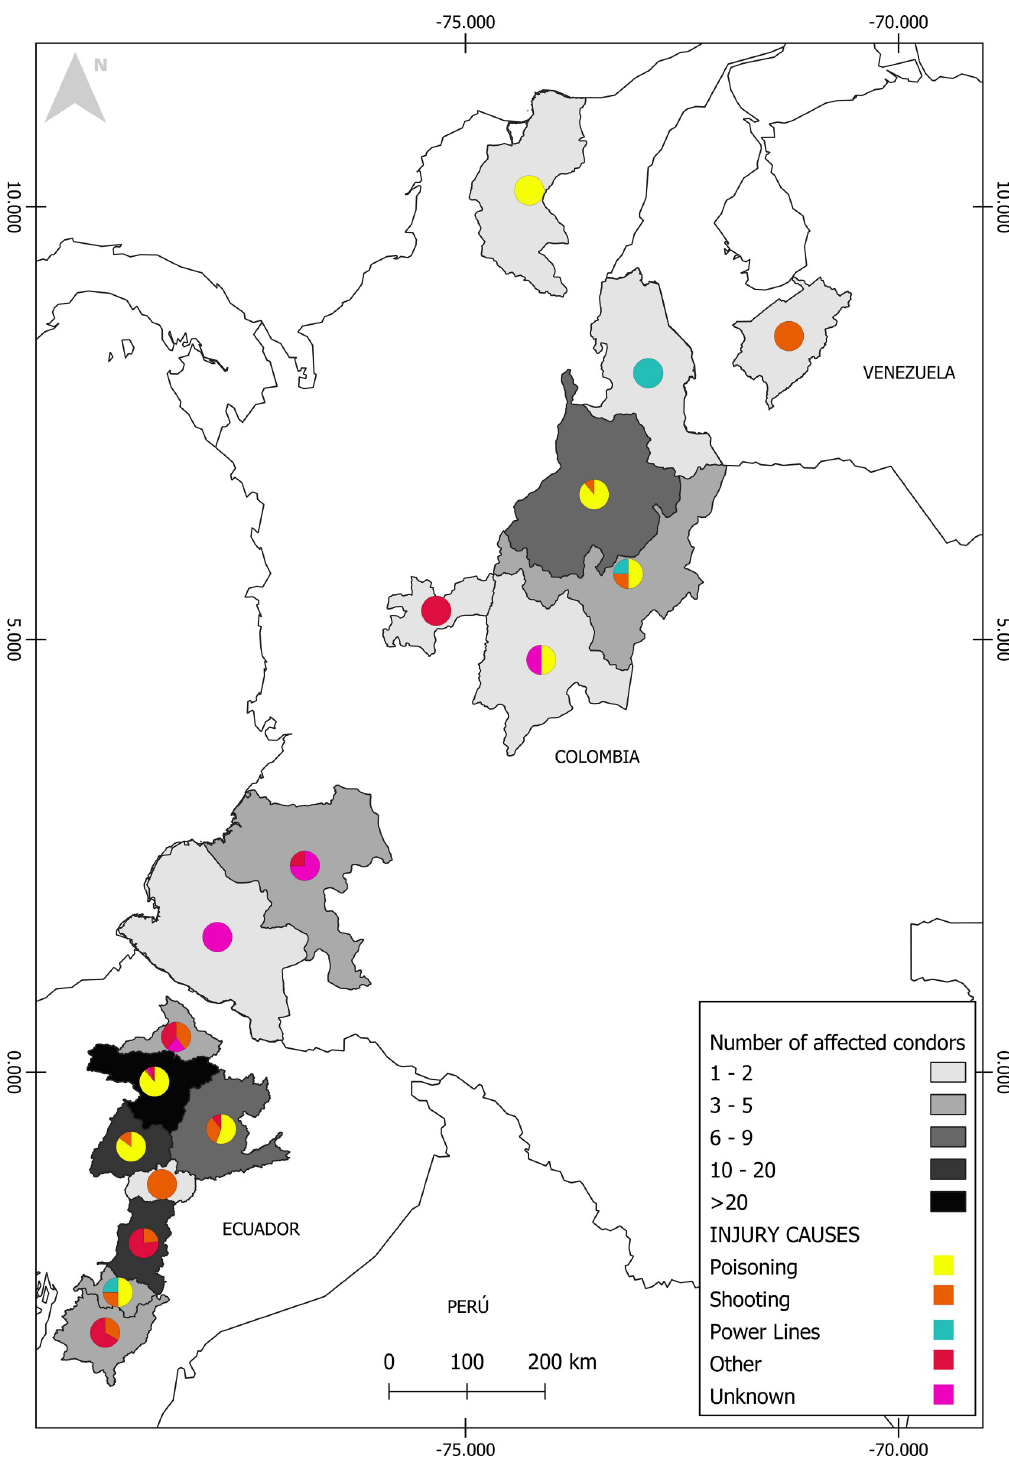
Fig 1. Number of Andean Condors affected by poisoning, shooting, and other causes of injury in northern South America between 1979 and 2021. Reprinted from http://creativecommons.org/licenses/by/4.0/ under a CC BY license, with permission from Emily Chenette, original copyright